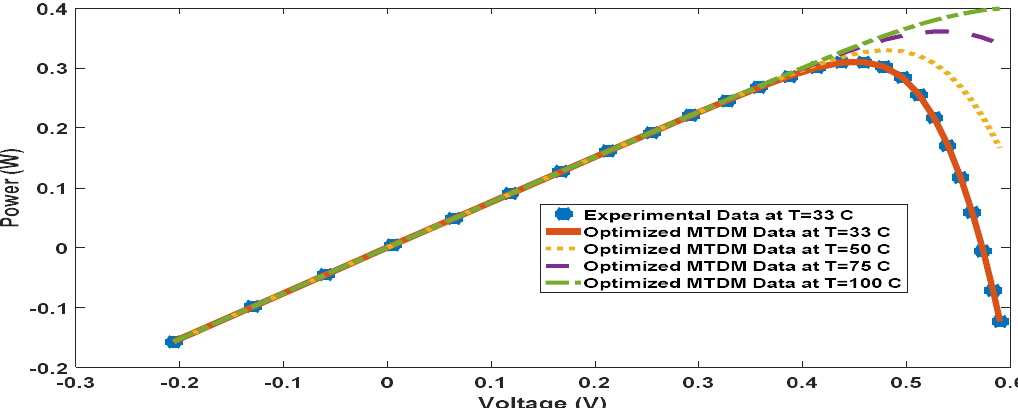
Figure 17. Power–voltage characteristic curve comparison between experimental current and TDM current estimated by WHO at different temperatures.